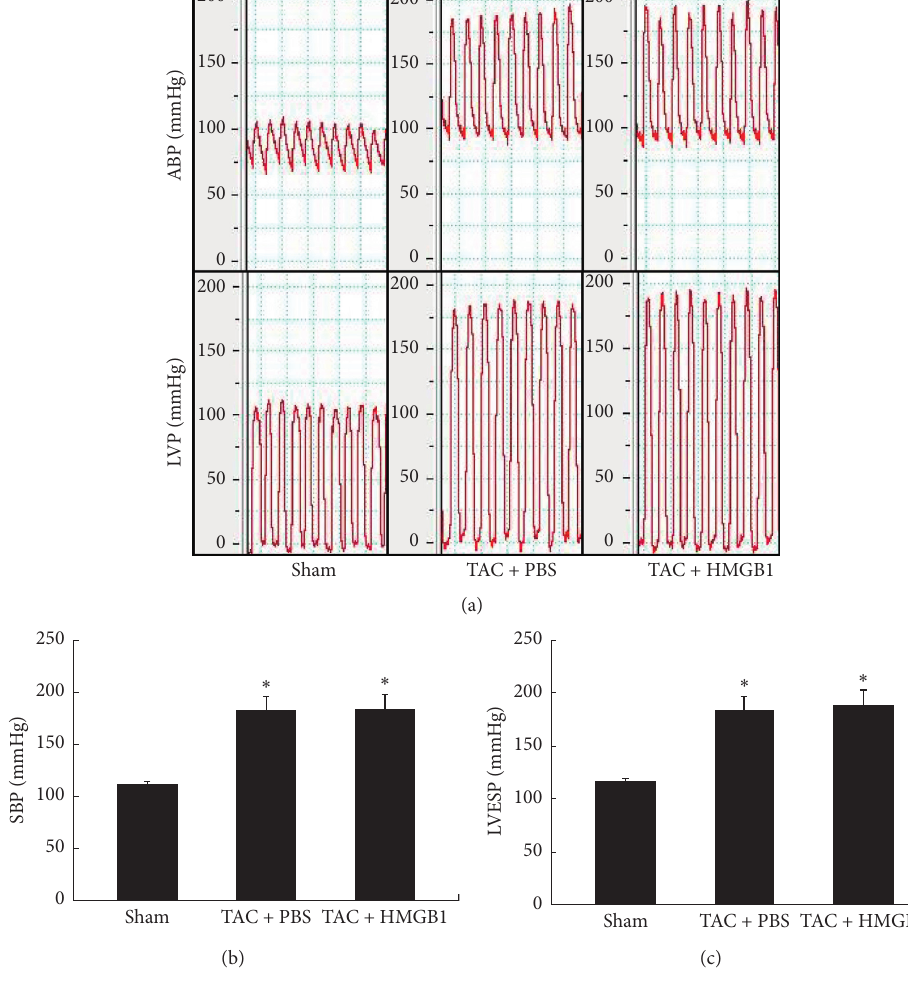
Figure 3: Haemodynamic assessment at 4 weeks after intervention. TAC: transverse aortic constriction; HMGB1: high-mobility group box 1; ABP: aortic blood pressure; LVP: LV pressure; SBP: systolic blood pressure; LVESP: left ventricular end-systolic pressure. Values